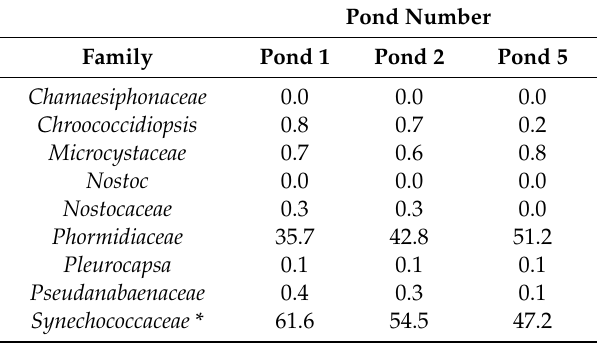
Table A7. Relative abundance for Cyanobacteria families. A * = Pond-indicator